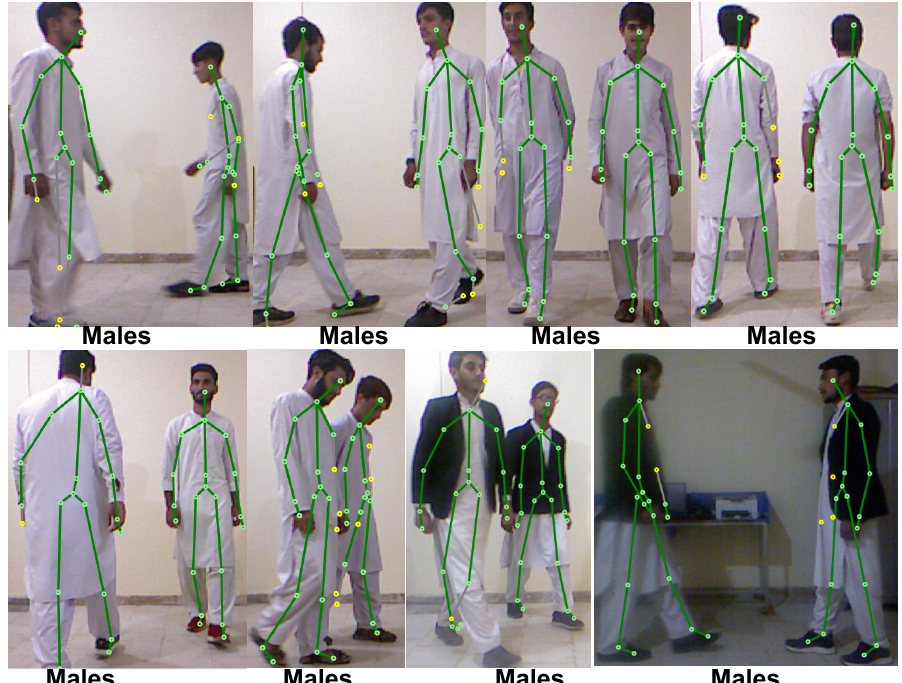
Figure 6. Walking of more than one subjects at the same time from different